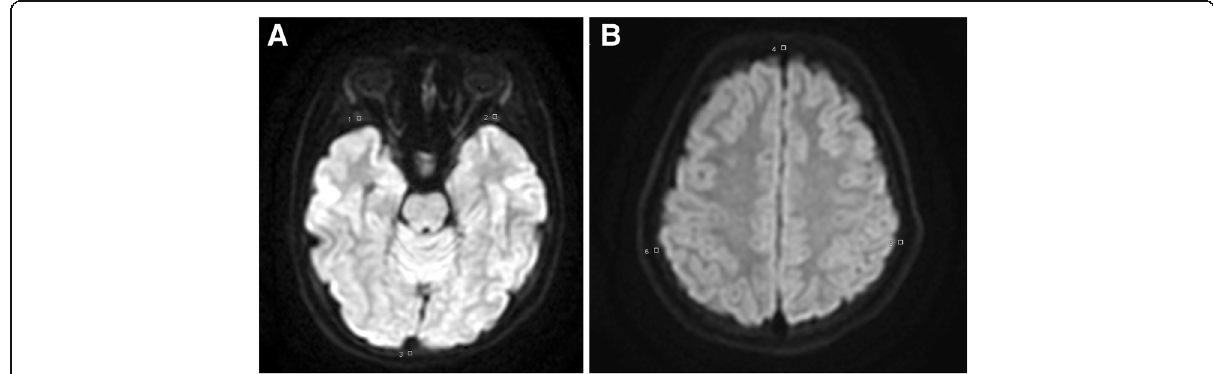
Fig. 3 DWI images of a 12-year-old control child showing the location of the different regions of interest used for ADC calculation. a ROIs placed in the right and left greater wing of sphenoid bone (ROI 1 and 2) and the occipital bone ROI 3). b ROI placed in the frontal bone (ROI 4) and both parietal bones (ROI 5 and